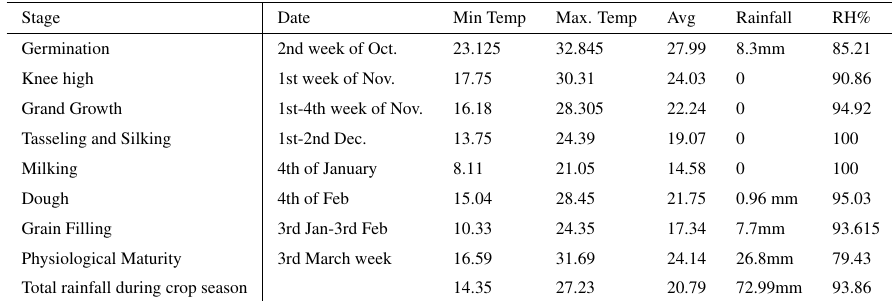
Table 1. Weekly maximum and minimum temperature, relative humidity, rainfall and solar radiation during research period at NMRP, Rampur, Chitwan, Nepal, 2015 /